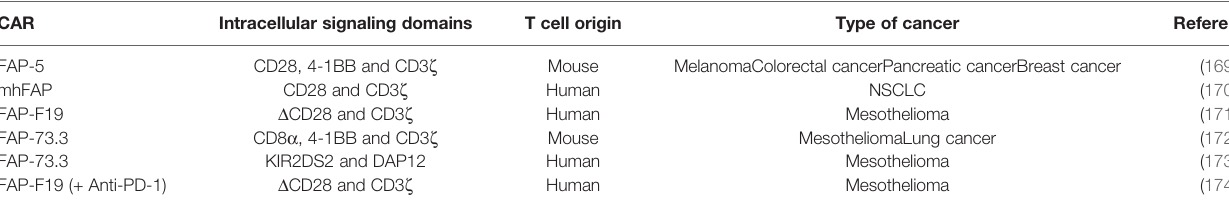
TABLE 4 | Summary of preclinical studies on FAP-targeted CAR-T